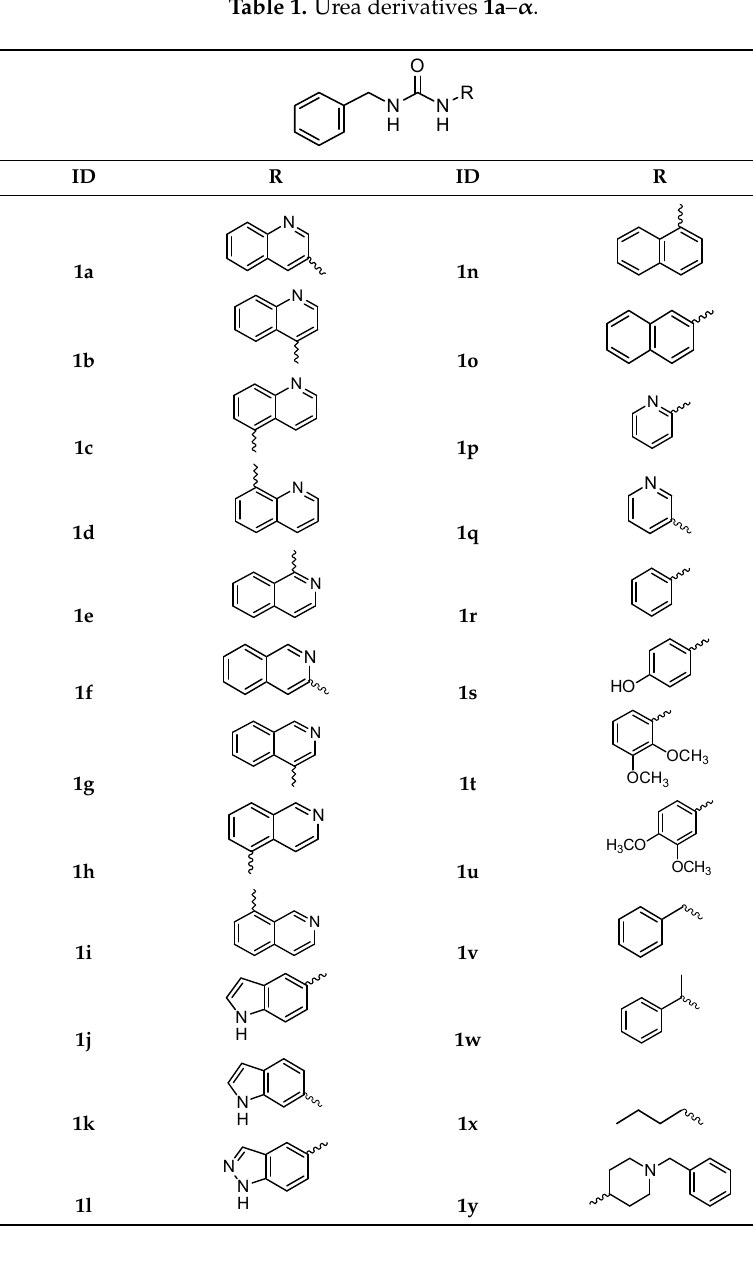
- Table 3. Amide and sulfonamide derivatives of isoquinolinyl urea 5 and 7 . Cpd